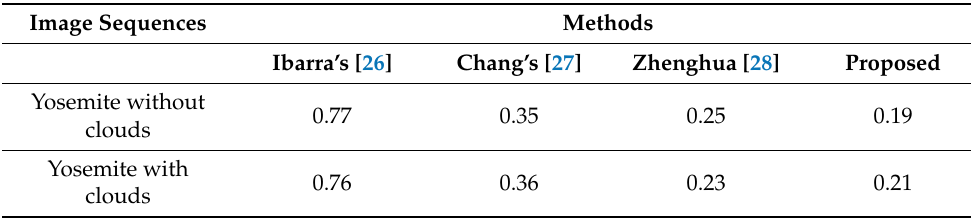
Table 1. Comparison of the average AE with other methods.